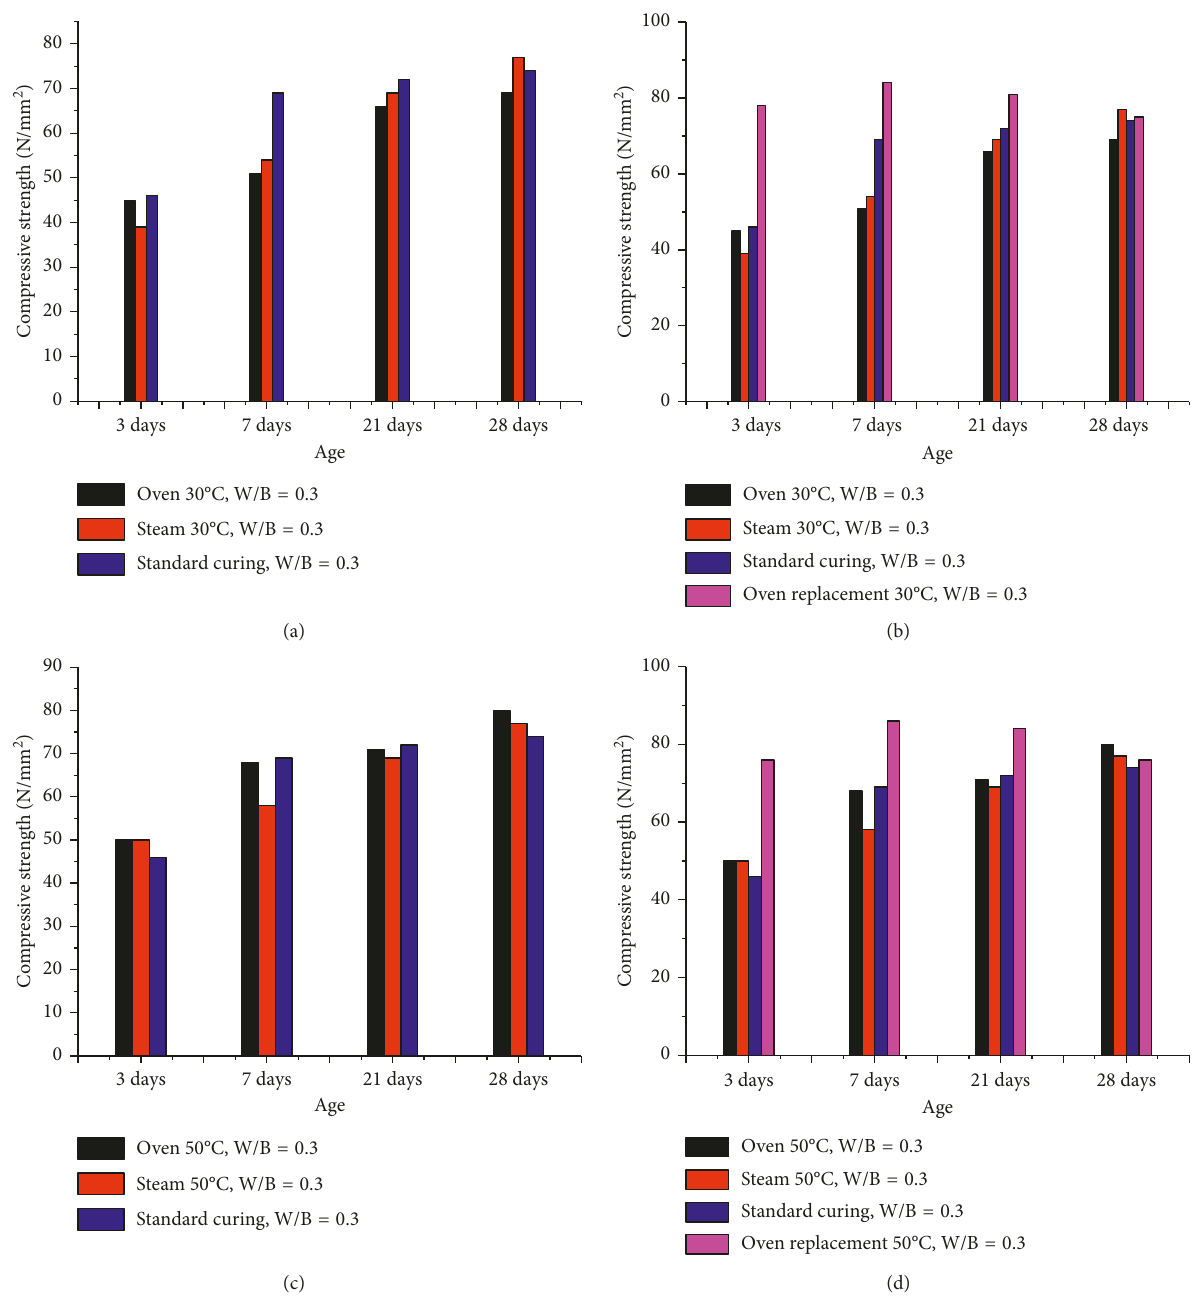
Figure 1: (a) Compressive strengths of concrete specimens with a W/B ratio of 0.3 prepared and cured under different conditions at a temperature of 30 ° C. (b) Compressive strengths of concrete specimens prepared with a W/B ratio of 0.3 and cured under oven replacement compared with different conditions at a temperature of 30 ° C. (c) Compressive strengths of concrete specimens with a W/B ratio of